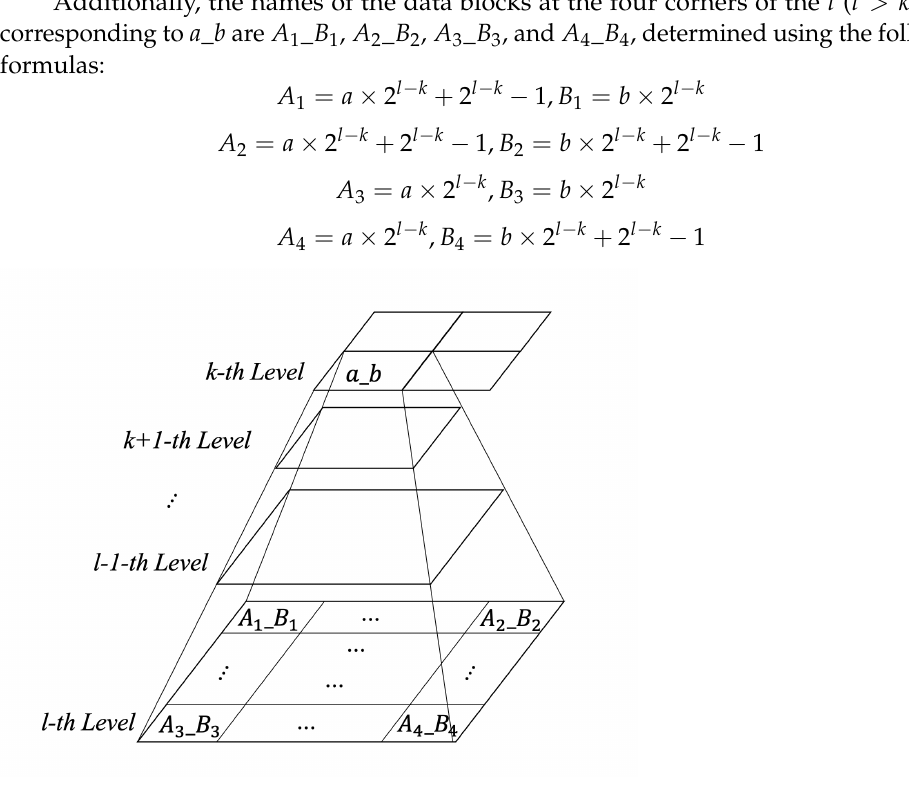
Figure 8. Quadtree storage structure